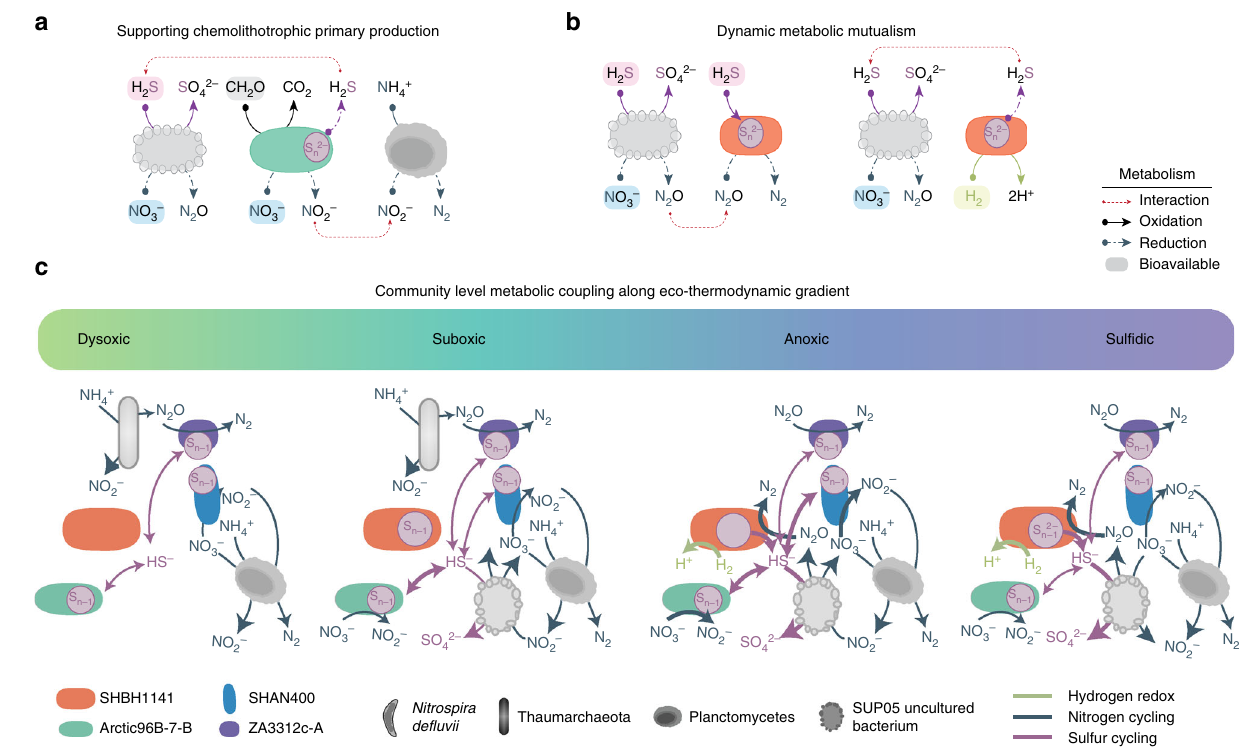
Fig. 5 Proposed co-metabolic model along eco-thermodynamic gradient in Saanich Inlet. a Proposed metabolic coupling between ARCTIC96B-1, SUP05, and Planctomycetes. b Proposed dynamic metabolic mutualism between SUP05 and SHBH1141. c Conceptual model for Marinimicrobia co-metabolic activity with other major microbial groups in Saanich Inlet along eco-thermodynamic gradients. Interactions based on expression data for sulfur (pink), nitrogen (blue), and hydrogen (green) for dominant Marinimicrobia clades in Saanich Inlet as well as putative metabolic partners Nitrosopumulaceae sp.,